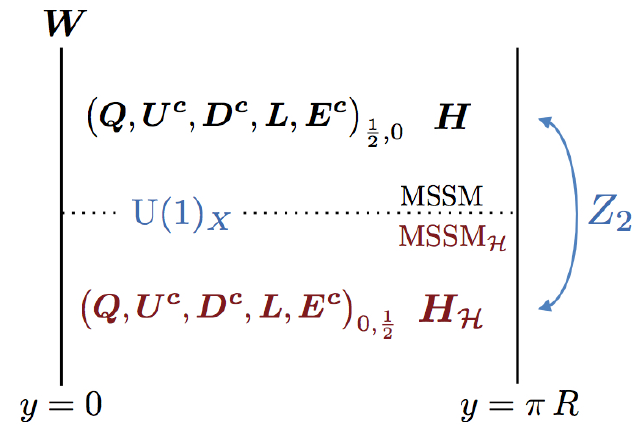
Figure 2 . A schematic representation of the model. The bold font signi(cid:12)es full supermultiplets, and the subscript are the Scherk-Schwarz twist parameters ( q B ; q F ). Note that 5D supermultiplets are equivalent to a vector-like pair of 4D supermultiplets. The Hyperbolic sector is denoted in red. The new U(1) X gauge group gives an interaction between the two sectors and the exchange symmetry Z 2 relates coupling constants, as well as interchanging the